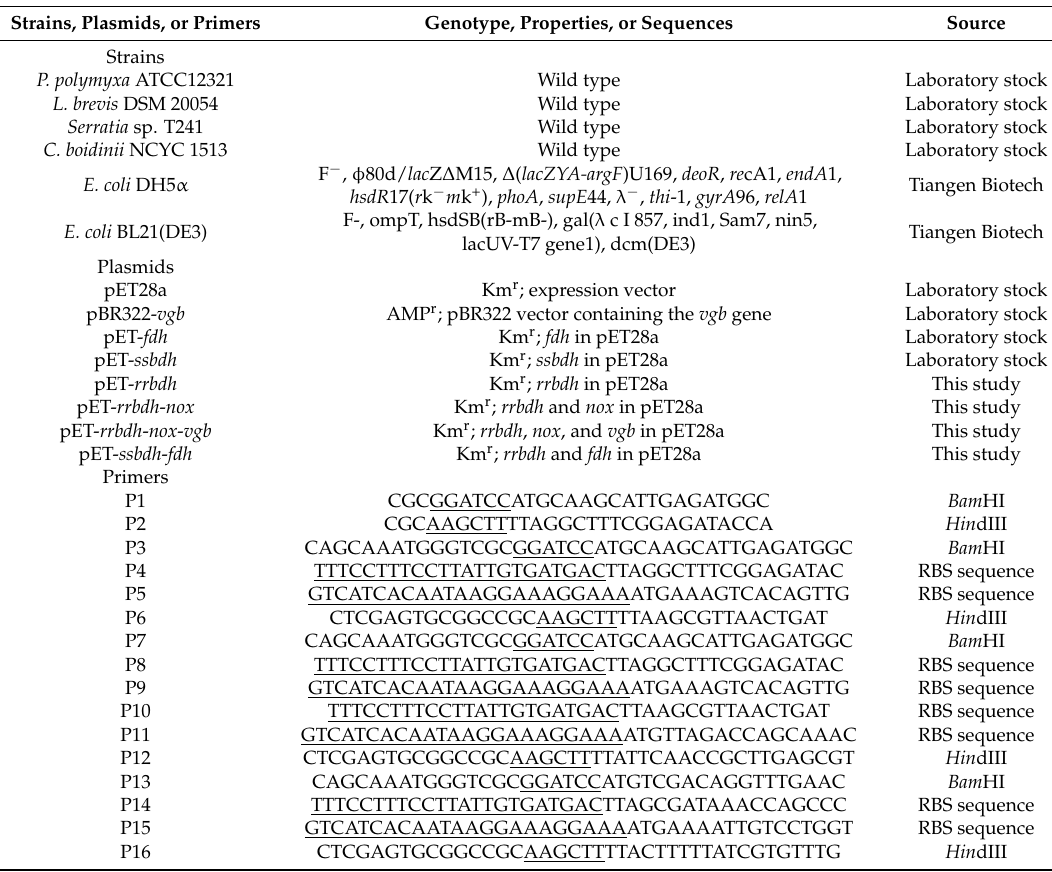
Table 4. Bacterial strains, plasmids, and primers used in this study. Strains, Plasmids, or Primers Genotype, Properties, or